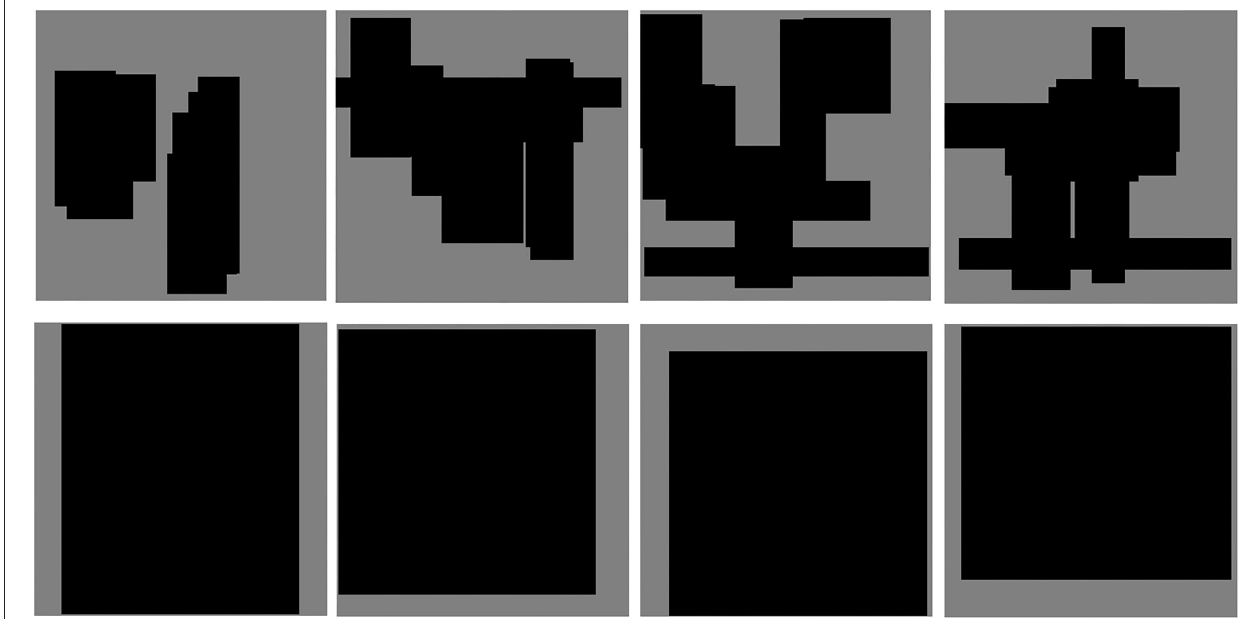
FIGURE 5 | Comparison of multi-matrix erasing (top) and single-matrix erasing (bottom).